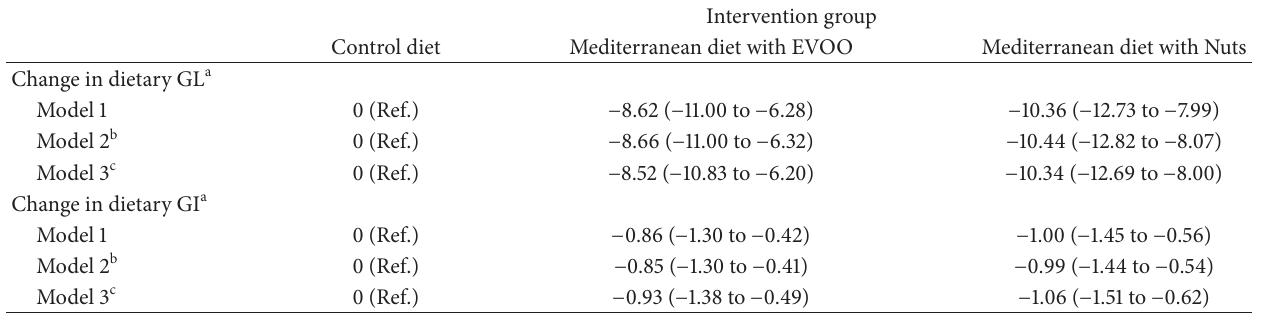
Table 2: Regression coefficients and 95% CI for GL and GI changes according to the intervention group at one year of follow-up ( 𝑛 = 2866 ). Intervention group Control diet Mediterranean diet with EVOO